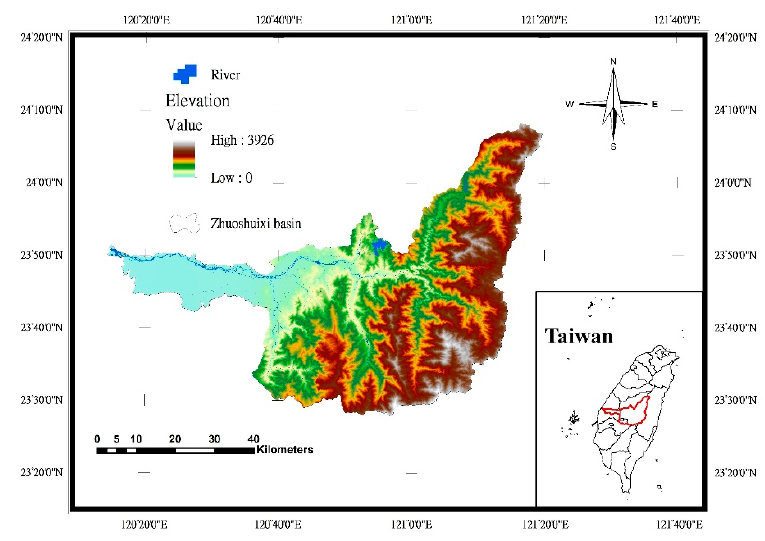
Figure 1. Site of the study area with DEM.